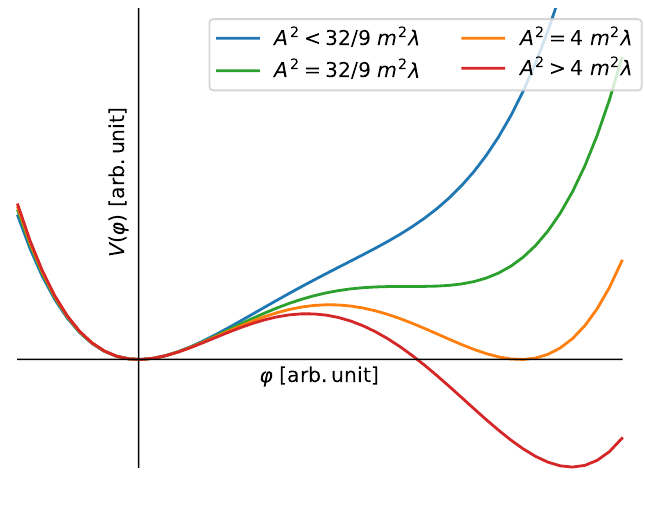
Figure 1 . Behaviour of the generic quartic potential as given in eq. (2.6) for di(cid:11)erent relations between the coe(cid:14)cients A , m 2 and (cid:21) as indicated in the legend for arbitrary units on both axes. PHC e(cid:14)ciently (cid:12)nds all solutions of systems of polynomial equations. We use it to